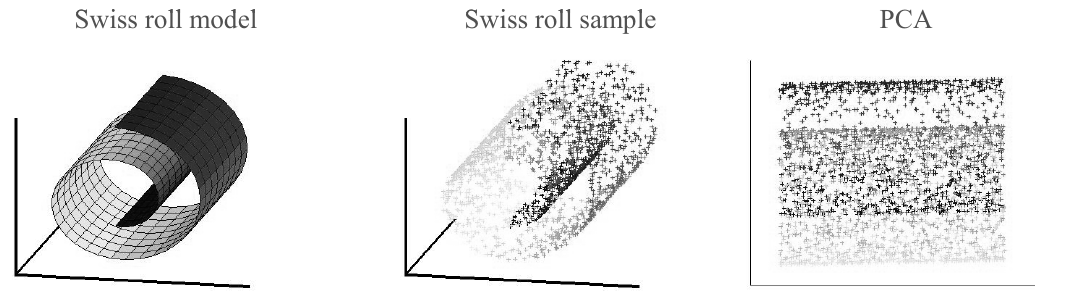
Figure 1 – Dimension reduction with PCA on Swiss role